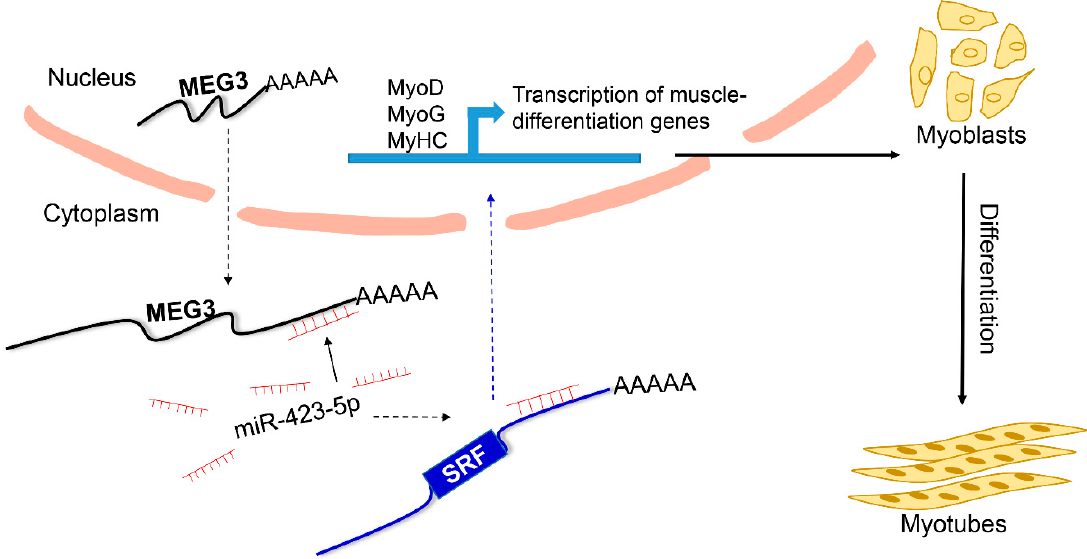
Figure 7. Proposed model of MEG3 regulatory mechanism in porcine satellite cell di ff erentiation. In this model, MEG3 , as a ceRNA, promotes porcine satellite cell di ff erentiation by sponging miR-423-5p to relieve the inhibiting e ff ect on SRF .